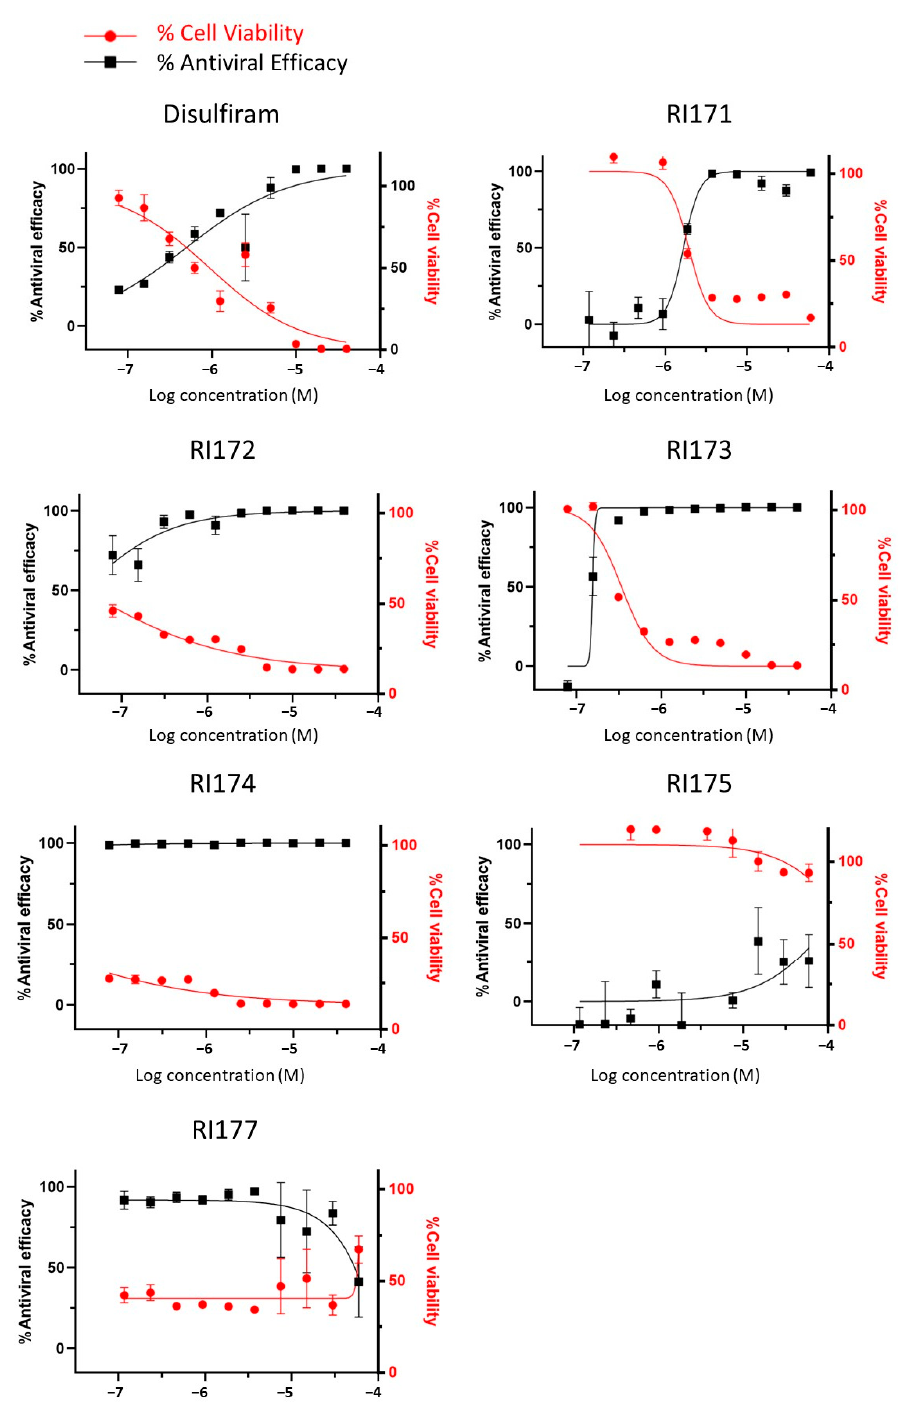
Figure 5. The antiviral efficacy and toxicity level of thiuram disulfide or dithiobis-(thioformate) analogs in the SARS-CoV-2 Huh7.5.1 cell-based infectivity assay. The antiviral activity (black solid square) against SARS-CoV-2 and cell viability (solid red circle) of disulfiram, RI171, RI172, RI173, RI174, RI175, and RI177 at 60 to 0.080 μ M obtained from the immunofluorescence signal and normalized compared to the untreated control (0% inhibition) and non-infected control (100% inhibition and 100% cells viability). The half maximal effective concentration (EC 50 ) and cytotoxic concentration (CC 50 ) of each compound were evaluated from the antiviral efficacy and cell viability normalized signals. Fitting was performed using GraphPad Prism software.